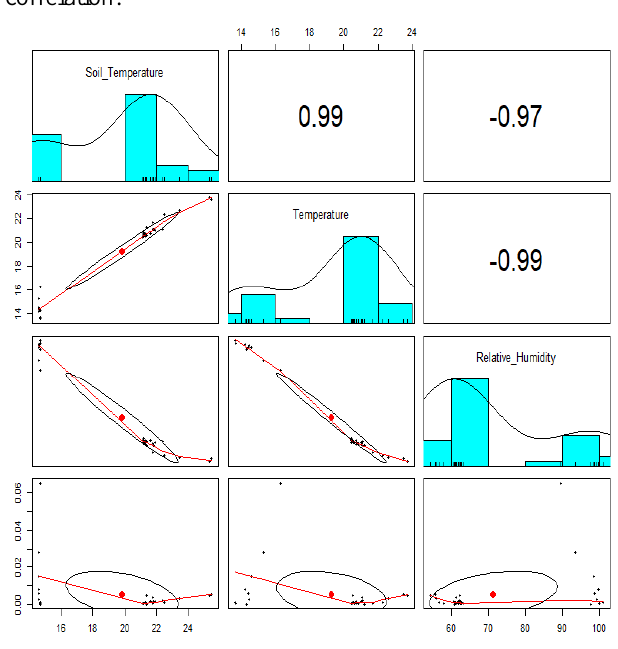
Figure 4 . Scatterplot matrix showing correlation of a selected set of weather